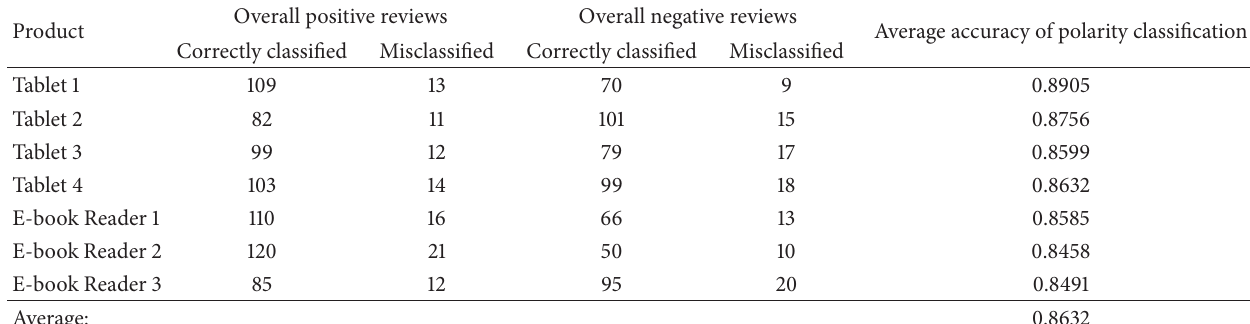
Table 4: Overall classification accuracy using multistep